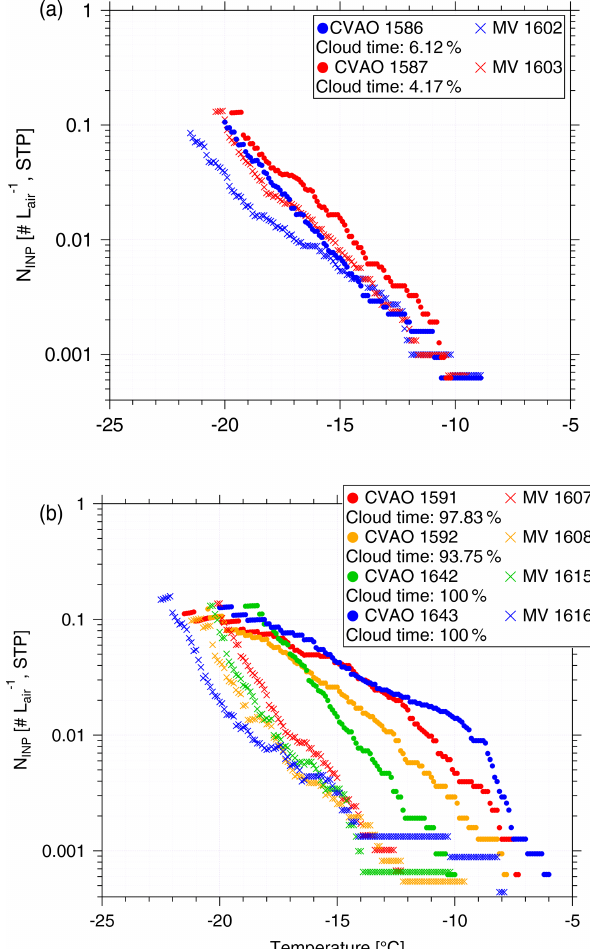
Figure 5. N INP as a function of temperature from CVAO PM 10 filters and MV PM 10 filters during (a) less (cloud time fraction < 10%) cloud effected periods and (b) highly (cloud time fraction > 90%) cloud effected